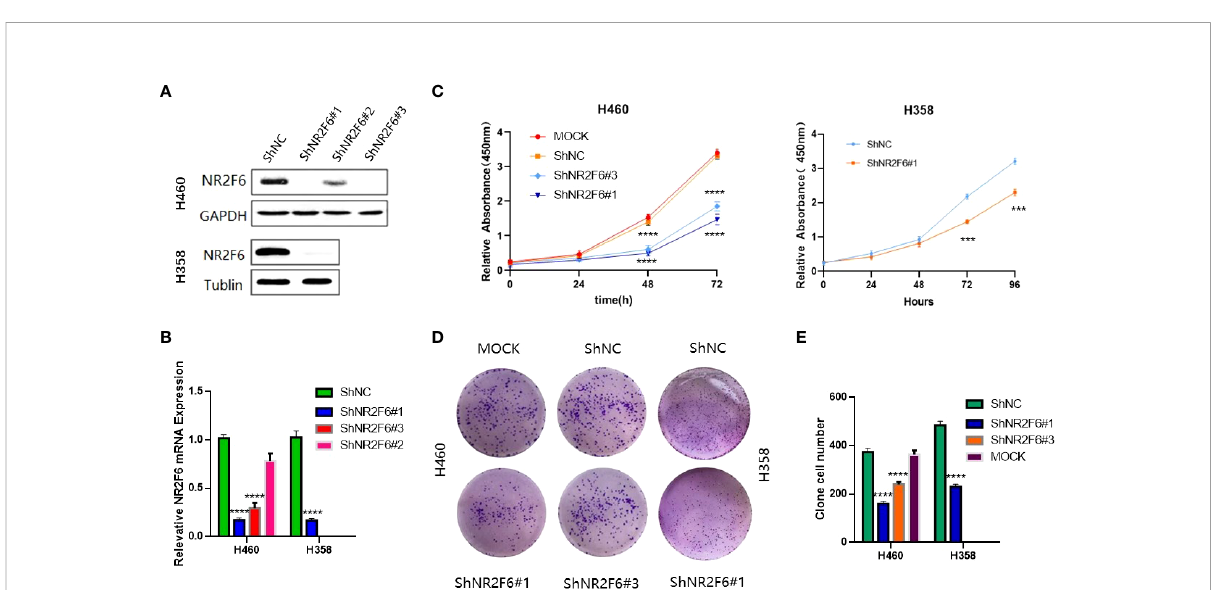
FIGURE 3 Knockdown of NR2F6 to inhibit the proliferation of H460 and H358 lung cancer cells. (A) Western blot test of NR2F6 protein levels in H460 and H358 cells and stale knockdown ef fi ciency. (B) Quantitative polymerase chain reaction test of NR2F6 transcriptional level in H460 and H358 cells and stale knockdown ef fi ciency. (C) The CCK8 results showed that the knockdown of NR2F6 in H460 and H358 cells signi fi cantly inhibits cell proliferation. (D) The knockdown of NR2F6 can reduce the clonality of H460 and H358 cells. (E) Statistical chart of cell count formed by clone. The above test results are the mean ± standard deviation of three independent repeated experiments. The mock group is the untransfected virus group. shNC is the NR2F6 knockdown control group. shNR2F6#1 and shNR2F6#3 are NR2F6 stable knockdown groups. *** P < 0.001, **** P <